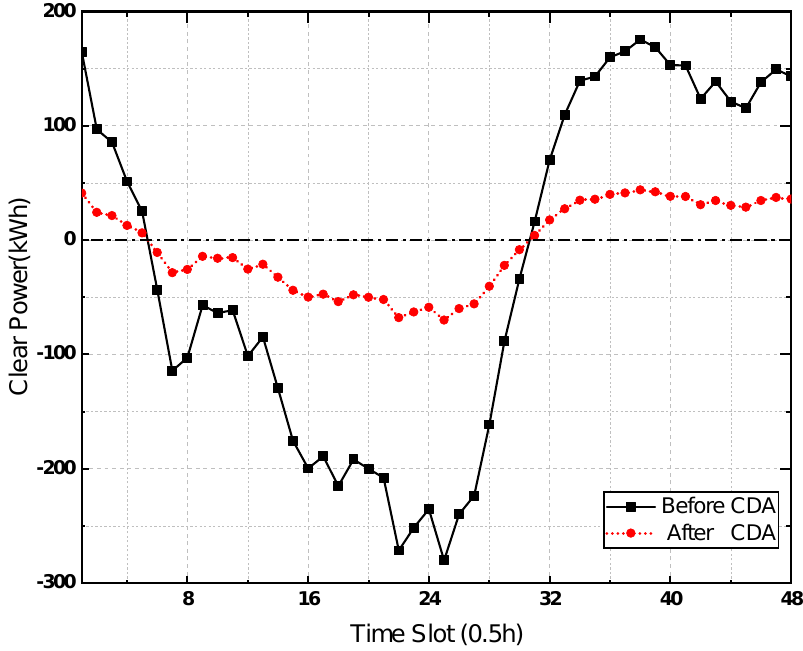
Figure 11. Clear power of the overall energy trading market before/after continuous double